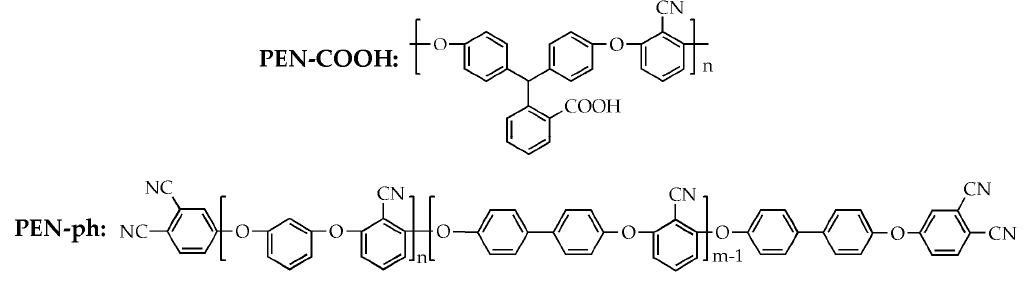
Figure 1. The structures of carboxyl-functionalized polyarylene ether nitrile (PEN–COOH) and polyarylene ether nitrile terminated with phthalonitrile (PEN-ph).